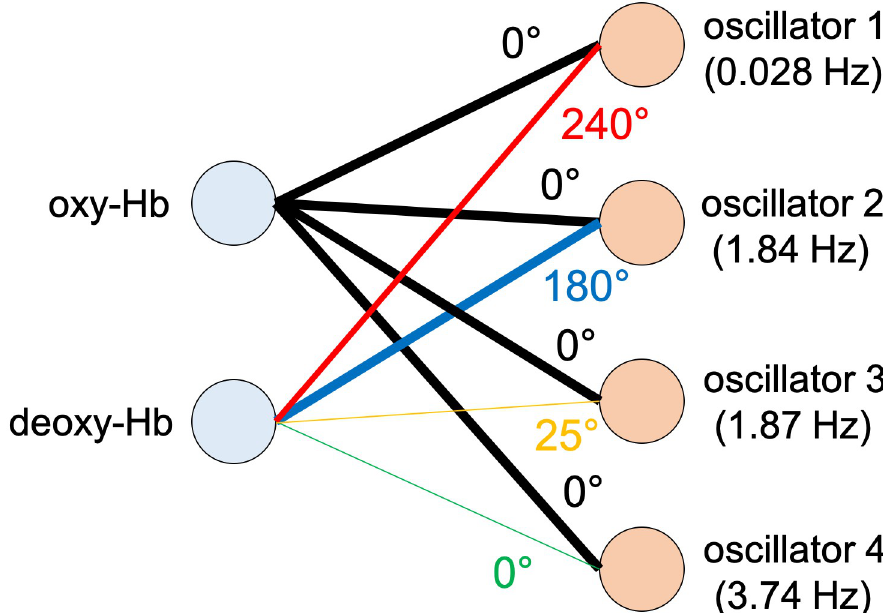
Fig 9. Estimated projection pattern for infant fNIRS data in Figs 7 and